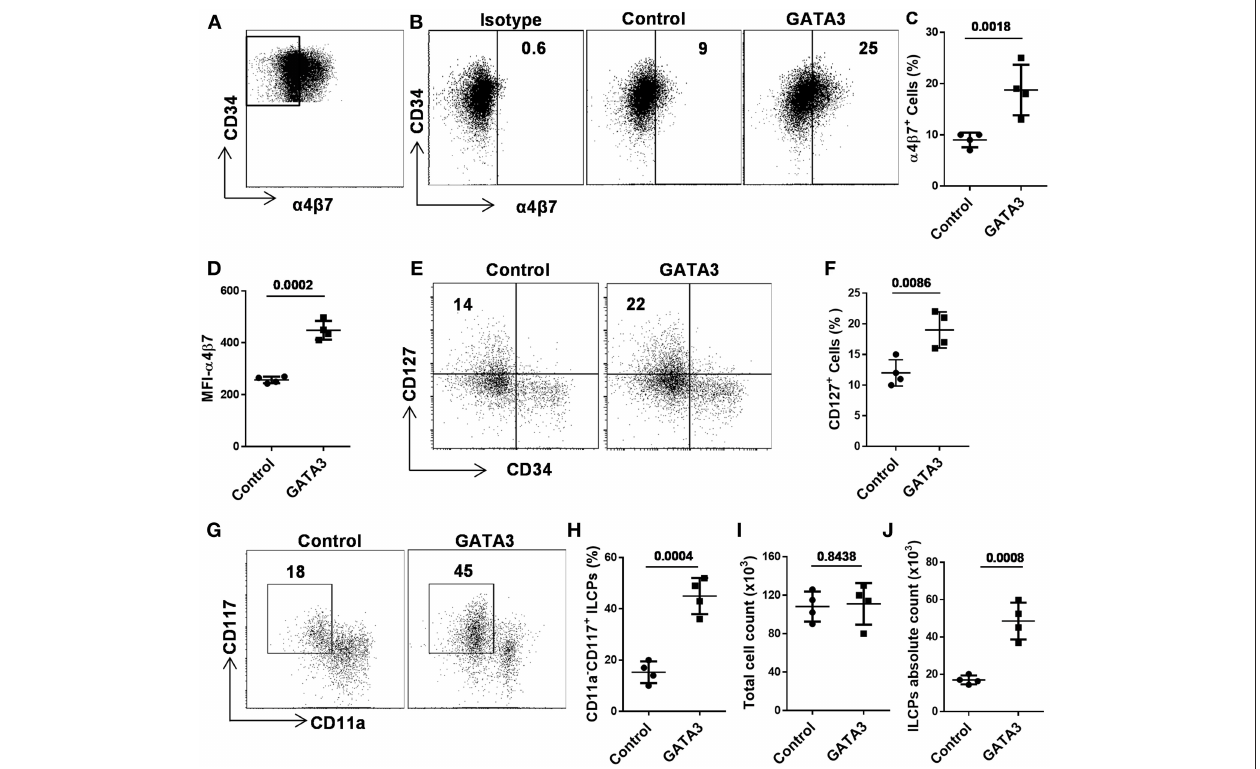
FIGURE 4 | GATA3 induces the development of ILC progenitors. Five-day expanded UCB CD34 + α 4 β 7 − HSCs were transfected with either GATA3 mRNA (GATA3) or scrambled mRNA (control) and differentiated under conditions that favor the development of ILCs (A) Gating strategy, 5-days expanded CD34 + α 4 β 7 − HSCs were sorted by FACS. (B) CD34 + α 4 β 7 − HSCs were stained for the surface α 4 β 7 at day 7 post electroporation and dot plot is shown ( n = 4). Values represent the percentage of α 4 β 7 + cells. (C,D) CD34 + α 4 β 7 − HSCs were stained for the surface α 4 β 7 at day 7 post electroporation and the percentage (C) and MFI (D) of α 4 β 7 + cells is shown ( n = 4/group). (E) CD34 + α 4 β 7 − HSCs were stained for the surface CD127 at day 14 post electroporation and dot plot is shown ( n = 4). Values represent the percentage of CD127 + cells. (F) CD34 + α 4 β 7 − HSCs were stained for the surface CD127 at day 14 post electroporation and the percentage of CD127 + cells is shown in bar graph ( n = 4/group). (G) CD34 + α 4 β 7 − HSCs were stained for the surface CD11a and CD117 at day 14 post electroporation and dot plot is shown ( n = 4). Values represent the percentage of CD117 + CD11a − ILCPs. (H) CD34 + α 4 β 7 − HSCs were stained for the surface CD11a and CD117 at day 14 post electroporation and the percentage of CD117 + CD11a − ILCPs is shown in bar graph ( n = 4/group). (I) Total counts of transfected and differentiating HSCs were performed at day 14 of culture and live cells in 1mL of culture media is depicted ( n = 4/group). (J) Absolute counts of CD117 + CD11a − ILCPs in 1mL of culture media is depicted ( n = 4/group). (C,D,F,H–J) , Data are shown as means ± SD, and p -values are depicted and paired two-tailed t